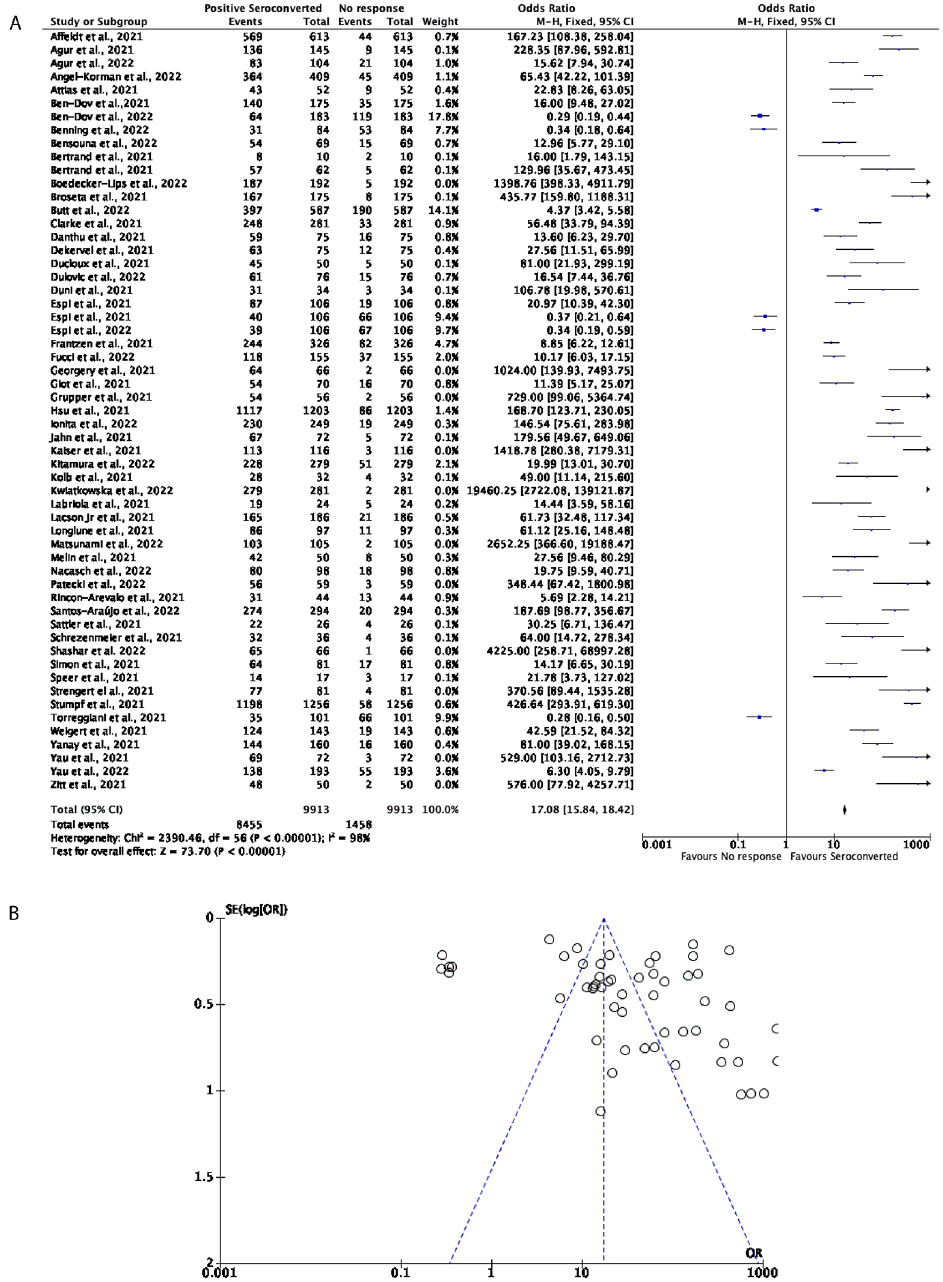
Figure 2. A total of 85% of Dialysis Patients (DPs) seroconvert after receiving two doses of a COVID-19 mRNA vaccine. (A) Forest plot comparison of the number of DPs who seroconverted or had no response after two doses of an mRNA vaccination (OR = 17.08, 95% CI = 15.84-18.42, P < 0.00001, I 2 = 98%). (B) Funnel plot evaluating heteroge- neity when comparing seroconversion response in DPs after two doses of an mRNA vaccine. Significant heteroge- neity was observed ( P < 0.00001, I 2 =